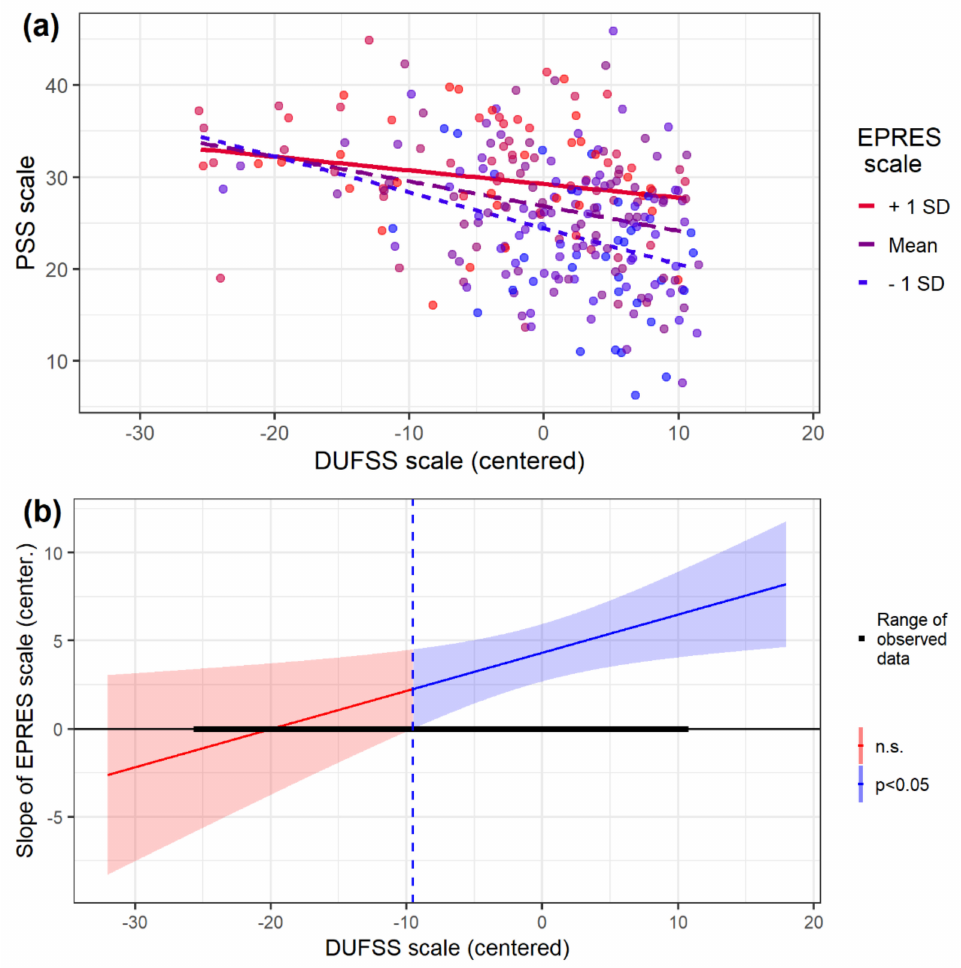
Figure 2. Plot of interaction of EPRES and DUFSS scales ( a ) and region of significance of the EPRES slope ( b